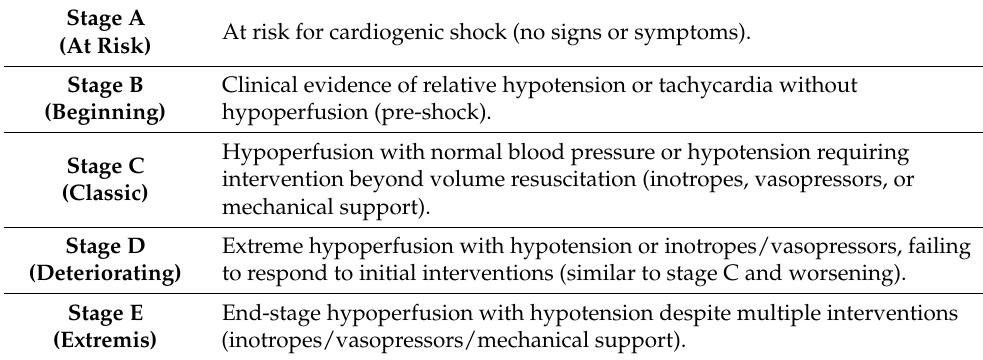
Table 1. SCAI (Society for Cardiovascular Angiography and Interventions) stages of cardiogenic